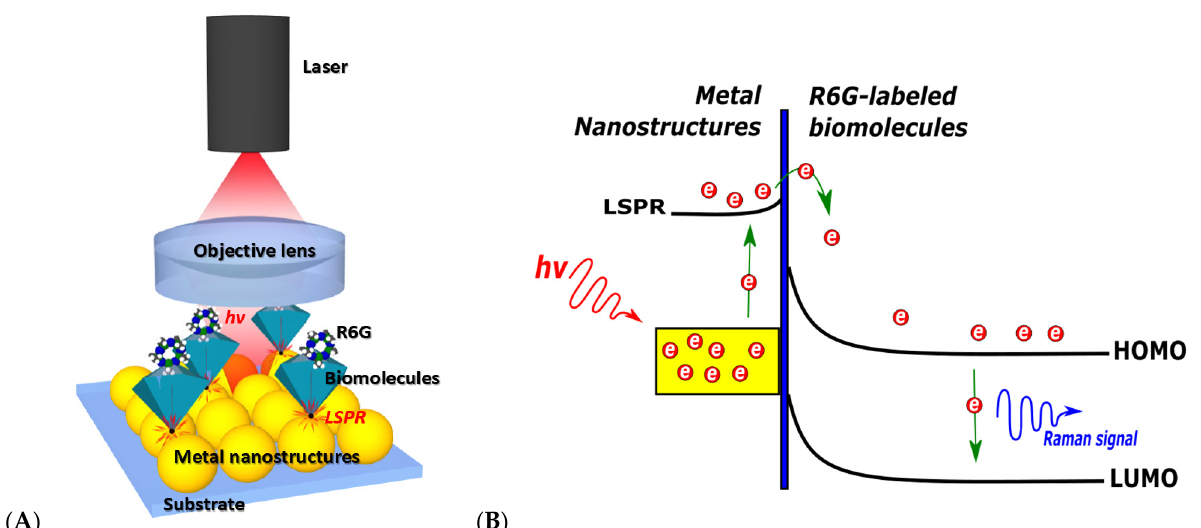
Figure 5. ( A ) Illustration of SERS-based biosensors using Rhodamine 6G (R6G) as the biomolecule label on the sensing structure with a gold nanosphere array. ( B ) The energy band diagram and electron transition illustration of SERS-based biosensors. Table 1. Comparison features and characteristics of biosensor